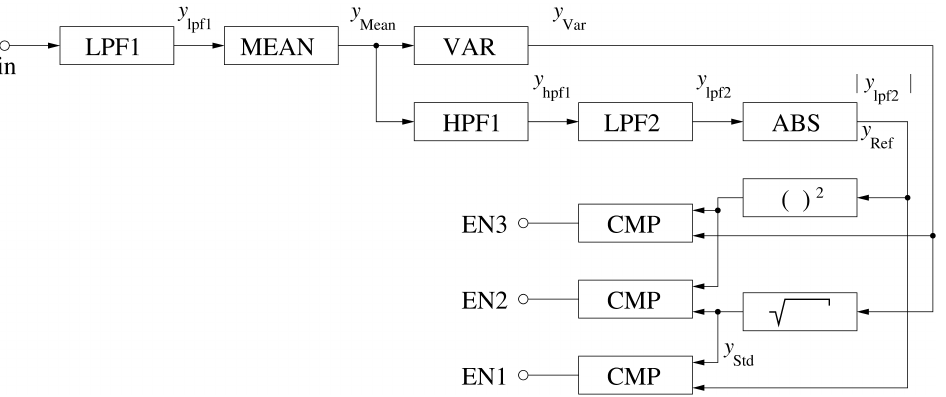
Figure 4. Structure of the proposed algorithm supporting the radio-frequency (RF) communication